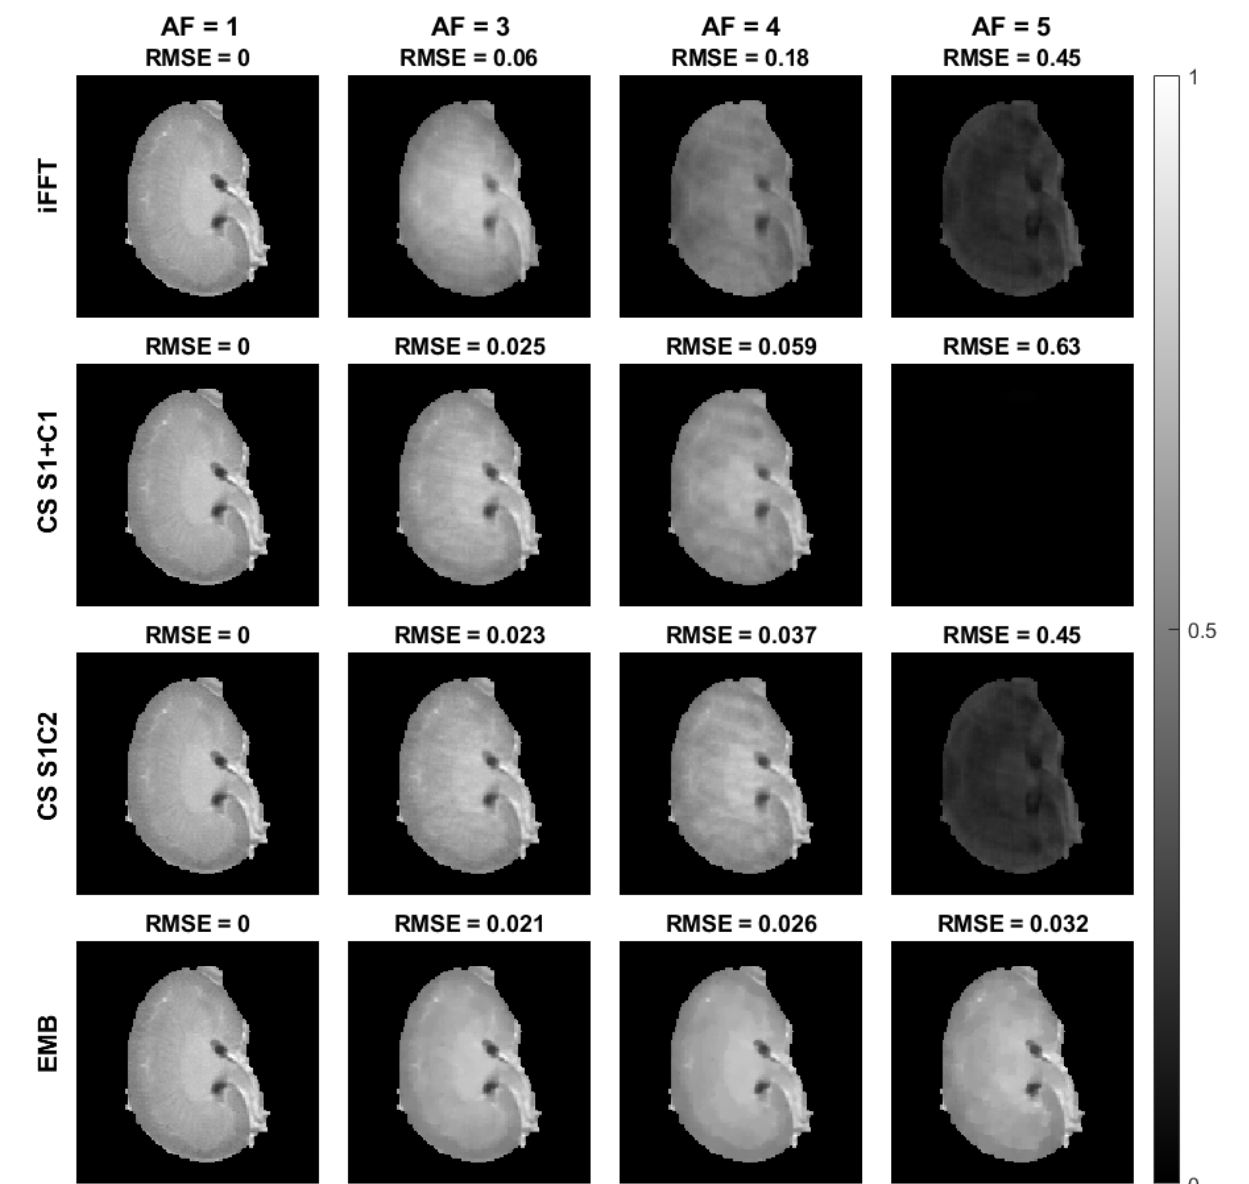
Figure 8. The S 0 maps of the cartesian ex vivo mouse kidney data with the iFFT, CS S1+C1, CS S1C2, and embedded models, as well as the RMSEs as compared to the corresponding model reconstructions with full data. The S 0 maps shown here are from the same reconstructions as the T 1 ρ maps shown in Figure 7. The top row contains the iFFT, the second row the CS S1+C1, and the third row the CS S1C2 model S 0 parameter maps obtained from the monoexponential fit of Equation (15), and the bottom row contains the S 0 maps obtained from the embedded model reconstructions. Columns 1–4 show the parameter maps corresponding to acceleration factors 1, 3, 4, and 5. Images are cropped to